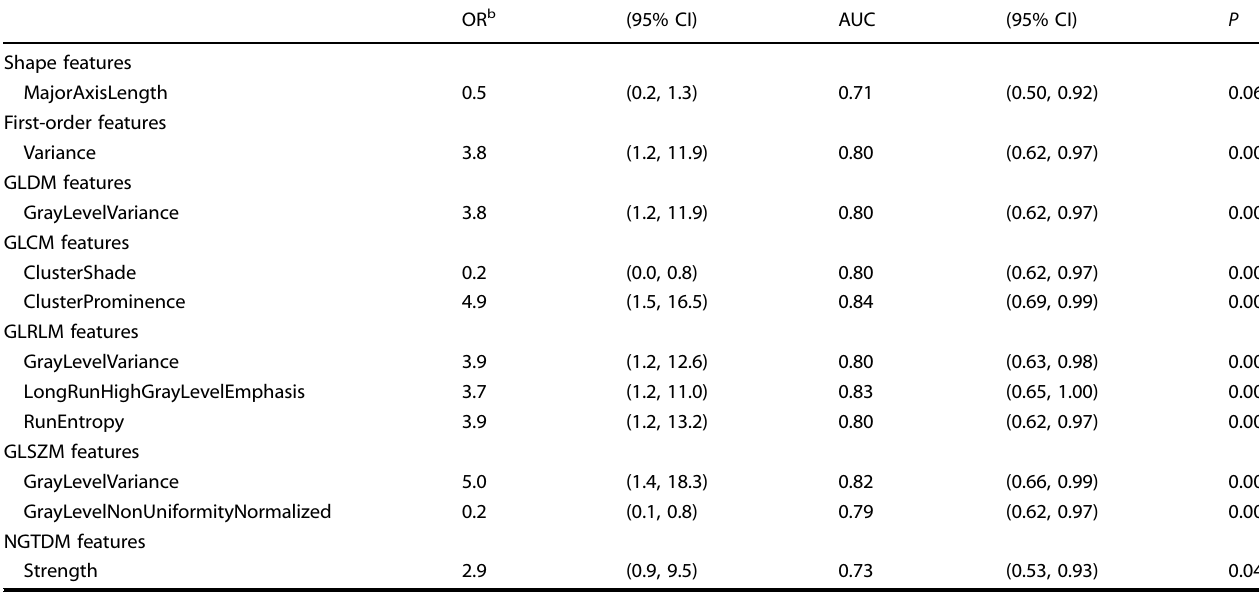
Table 3. Exploratory univariable analysis of associations between MVD and selected a DCE-MRI radiomic texture